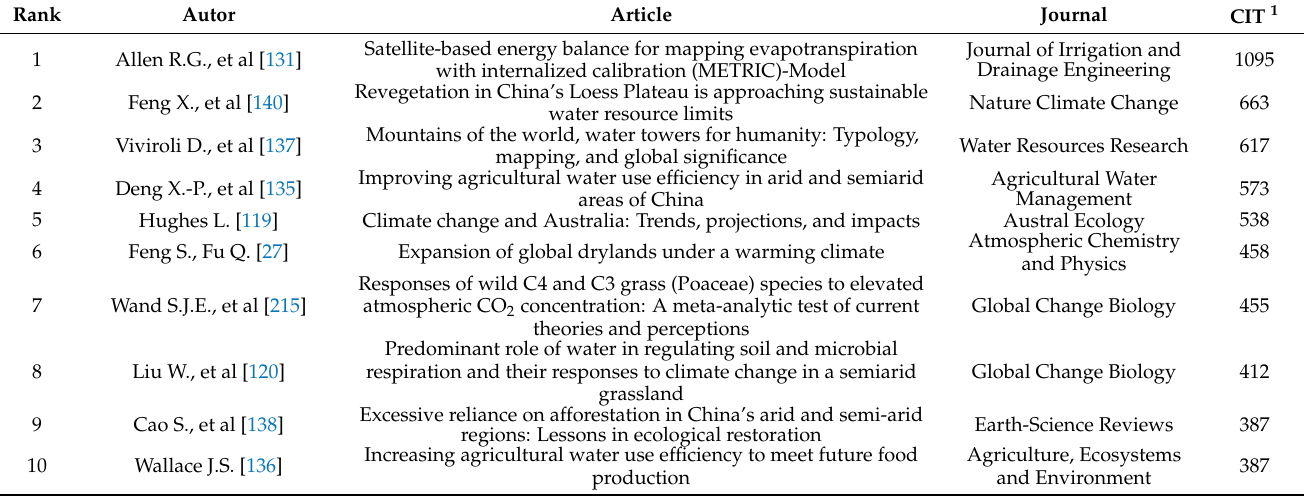
Table 1. Most cited